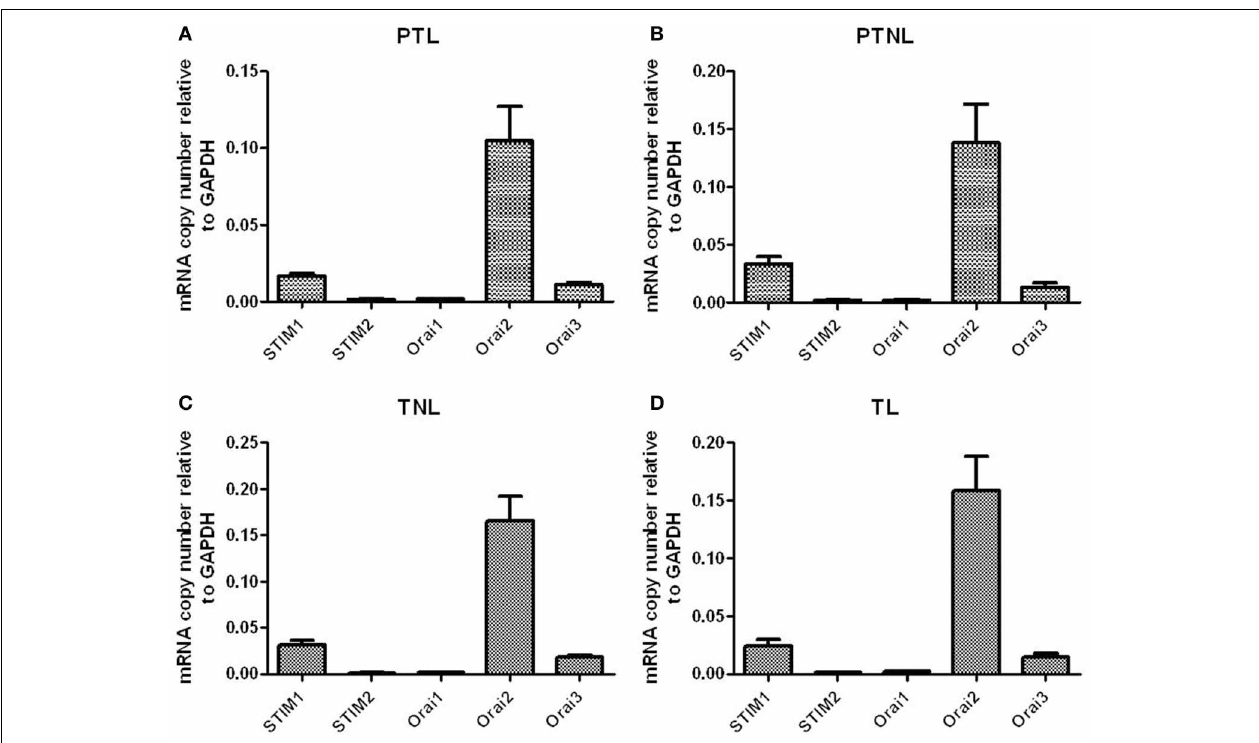
FIGURE 4 | STIM1/2 and Orai1-3 mRNA expression in pregnant human myometrial tissue taken from women at Cesarean section who were (A) preterm in labor (PTL, n = 4), (B) preterm but not in non labor (PTNL, n = 5), (C) term but not in labor (TNL, n = 6) and (D) term in labor (TL, n = 6).